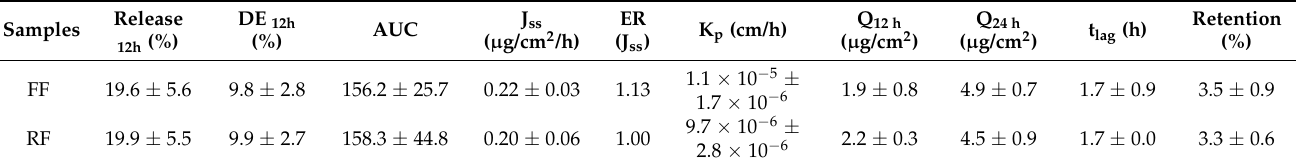
Table 3. Values obtained from the in vitro re 12 h. Data are mean ± SD, n =